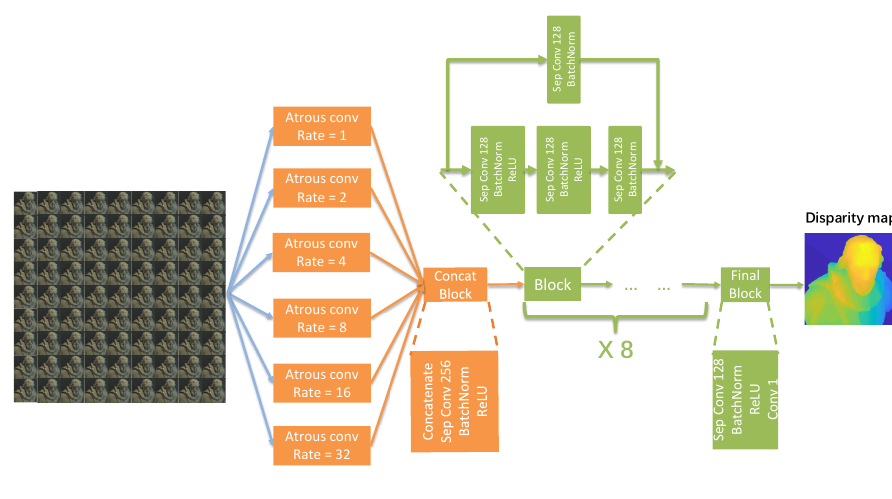
Figure 3. The structure of our